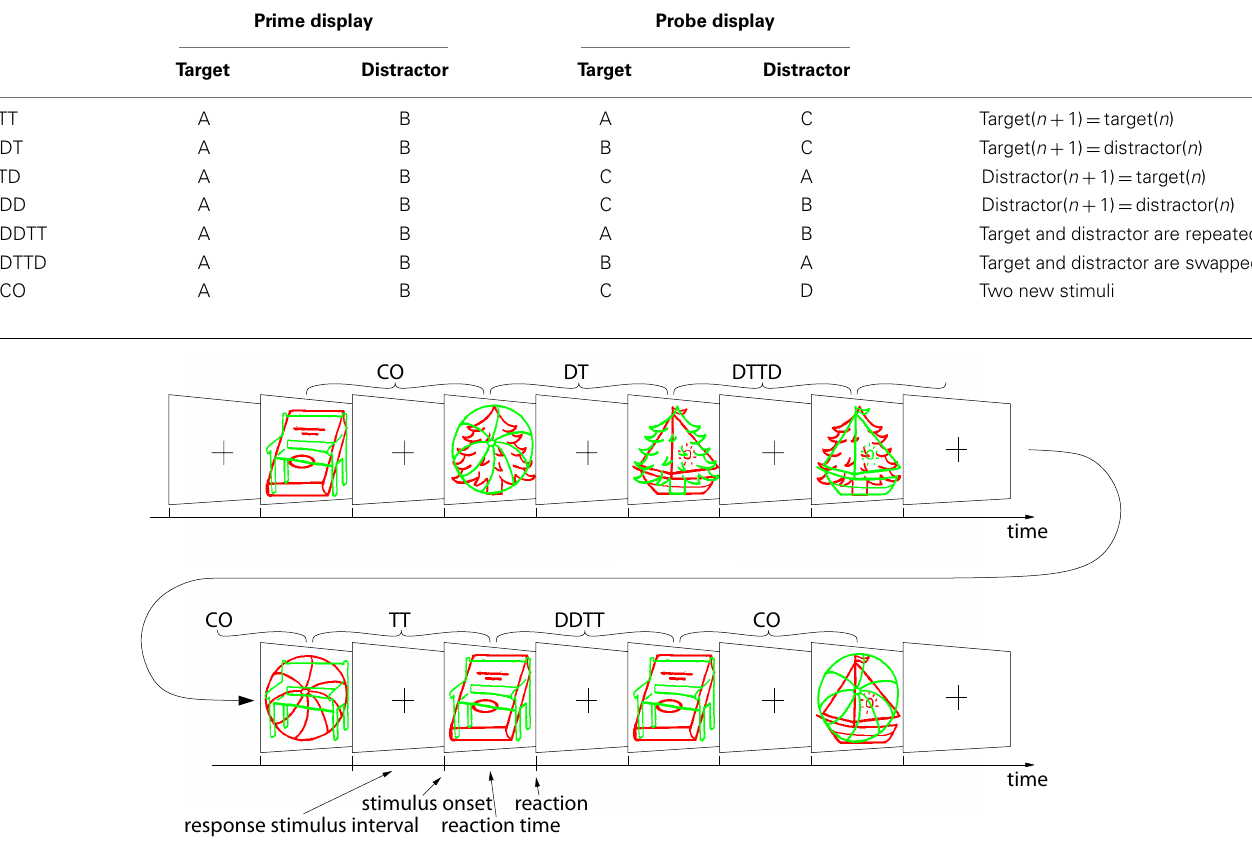
FIGURE 1 | Example of a sequence of stimuli. Consecutive screens are shown. Either stimuli or a blank screen followed by a fixation cross is displayed. Acronyms are explained in Table 1 .